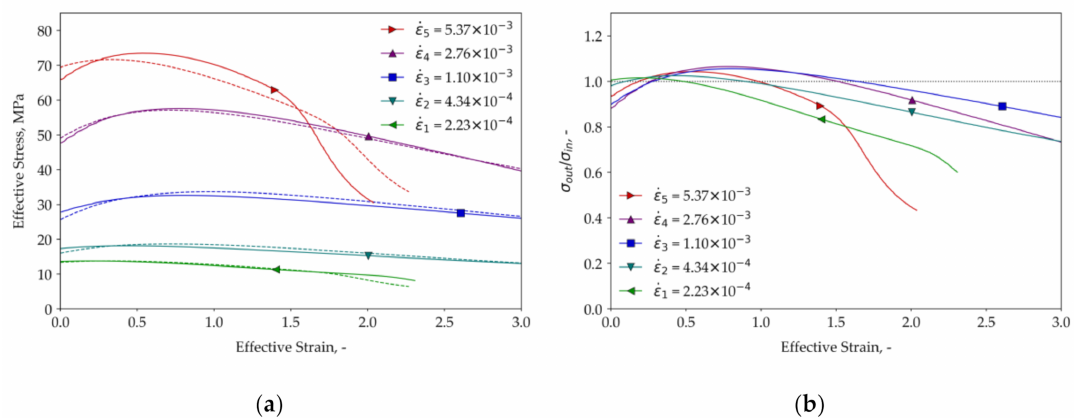
Figure 10. The e ff ect of strain rate on the stress–strain curves obtained by tensile testing: ( a ) the stress–strain curves obtained for di ff erent strain rates using the sigmoidal material model (solid) and its Backofen approximations (dashed); ( b ) the normalized stress evolutions obtained for di ff erent strain rates using the sigmoidal material model.